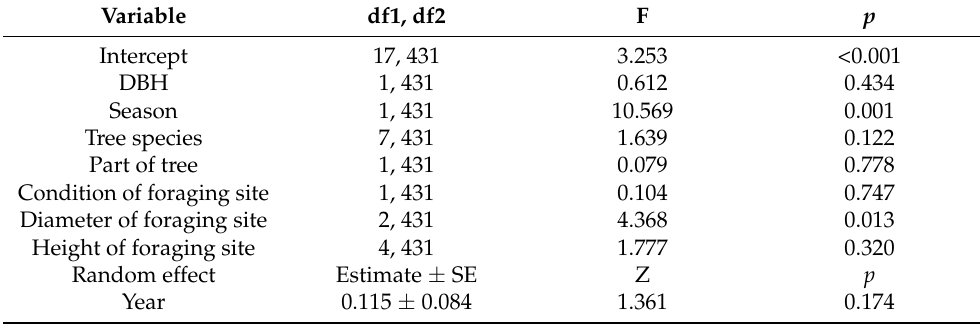
Figure 3. Least squares means with 95% confidence limits (from the statistical model presented in Table 3) of the duration of a foraging session of the Middle Spotted Woodpecker at sites with different diameters. Different letters indicate significant differences between different categories of foraging. Table 3. Results of GLMM analysis assessing the effect of variables on the duration of a foraging session of the Middle Spotted Woodpecker in primeval oak-lime-hornbeam forest in the BNP.